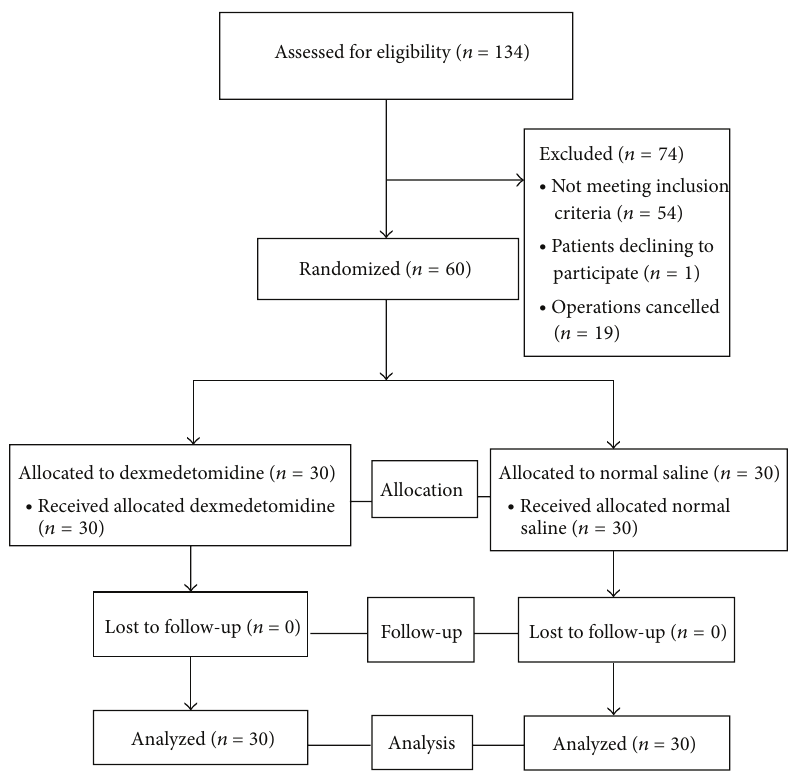
Figure 1: The Consolidated Standards of Reporting Trials flow diagram of the